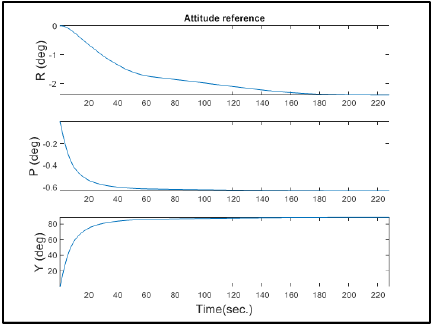
Figure 12. The reference attitude local level frame